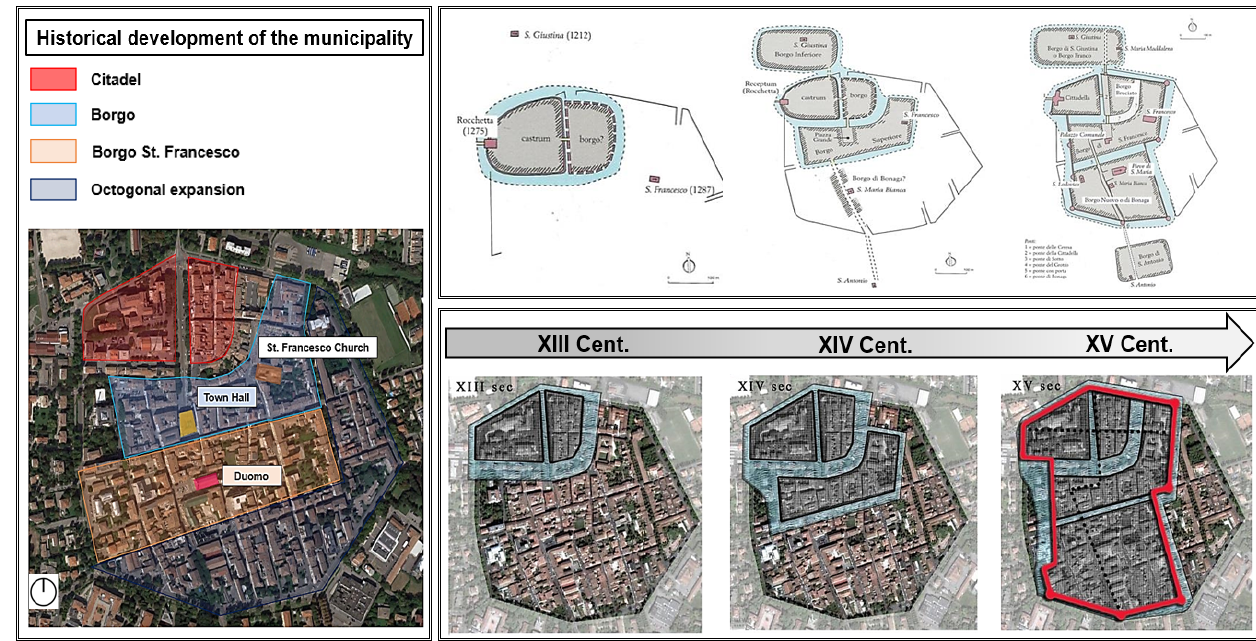
Figure 1. Historical urban conformation of the city of Mirandola [30]. On the left, a bird-eye view of the city, in which the highlighted areas indicate the urban expansion process, is illustrated. On the right, the urban development started from the “ancient village” (XIII Century) to the complete configuration of the citadel (XV Century).